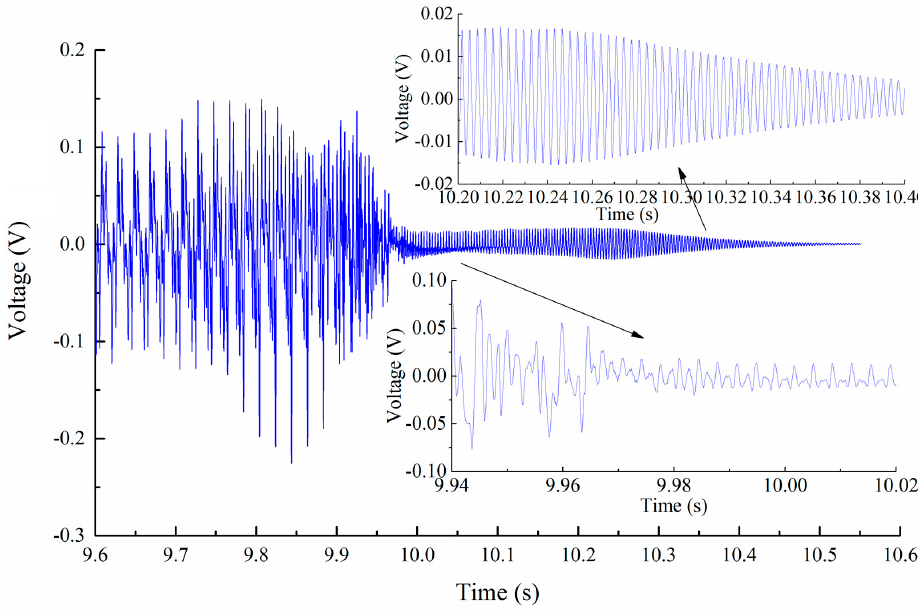
Figure 13. Workpiece deflection during the cutter exiting stage.